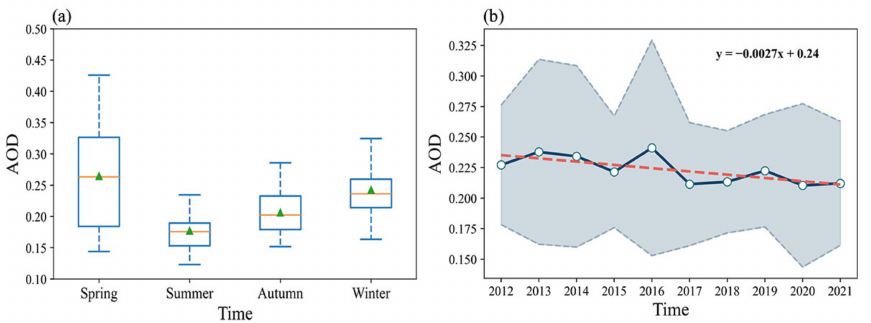
Figure 14. ( a ) Box diagram of AOD at 550 nm in different seasons, in which the green triangles represent the average value. ( b ) Temporal variations in the annual mean AOD at 550 nm over the study region from 2012 to 2021. Note these data are from